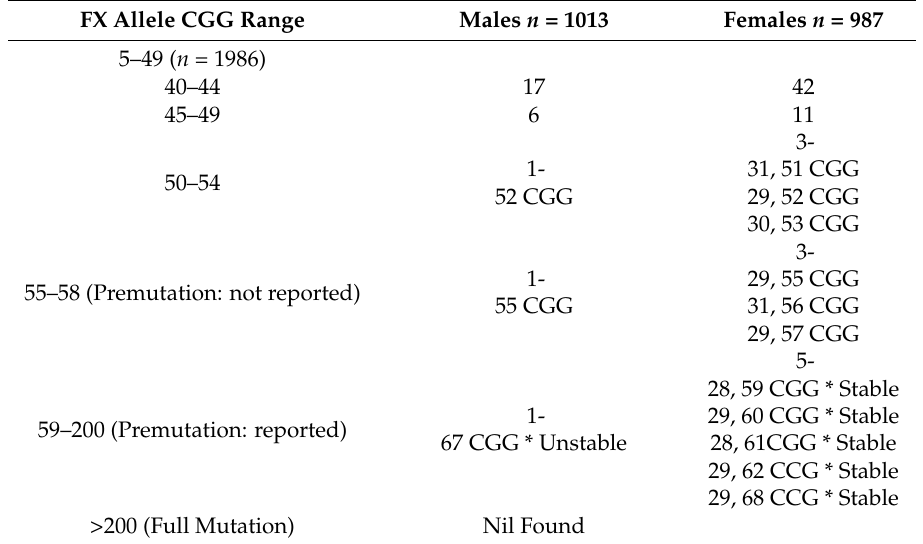
Table 3. Allele frequencies within the screened population, sized by the standard fragile X